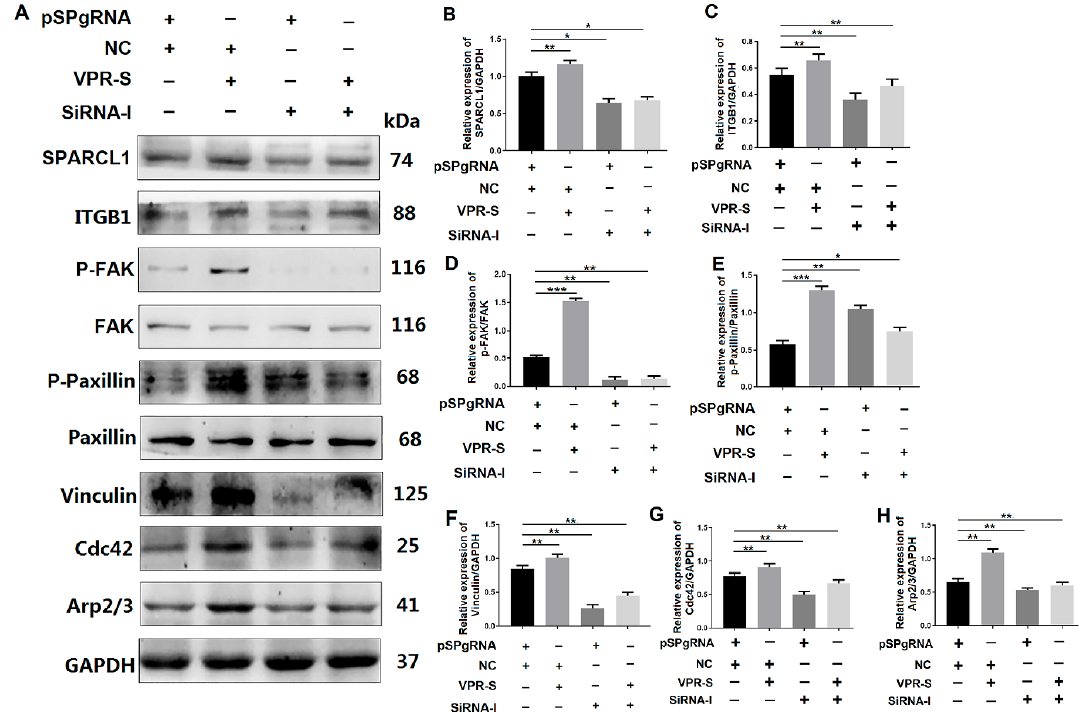
Figure 7. SPARCL1 regulates an ITGB1-mediated signaling pathway through ITGB1. ( A ) Western blotting results for ITGB1, p-FAK, FAK, p-paxillin, paxillin, vinculin, Cdc42, and Arp2 / 3 expression after SPARCL1 activation and ITGB1 inhibition. ( B – H ) Quantification of the Western blotting results presented in ( A ). pSPgRNA is the blank control for the SPARCL1 activation group, NC is the negative control for the ITGB1 siRNA interference group, VPR-S represents the SPARCL1 activation group, and siRNA-I represents the ITGB1 siRNA interference group. * p < 0.05, ** p < 0.01, *** p < 0.001.